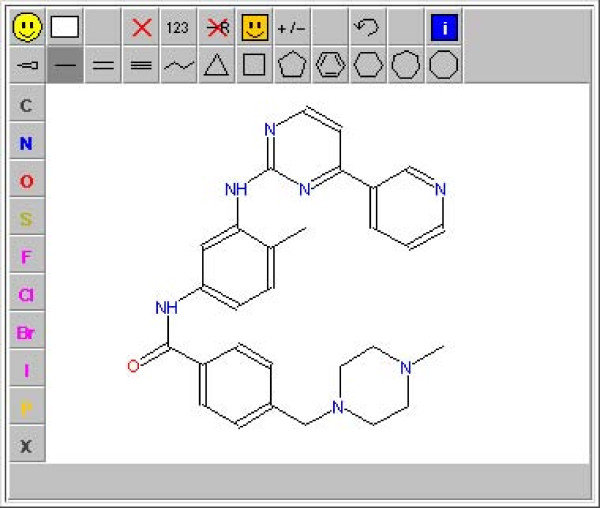
JME Molecule Editor.